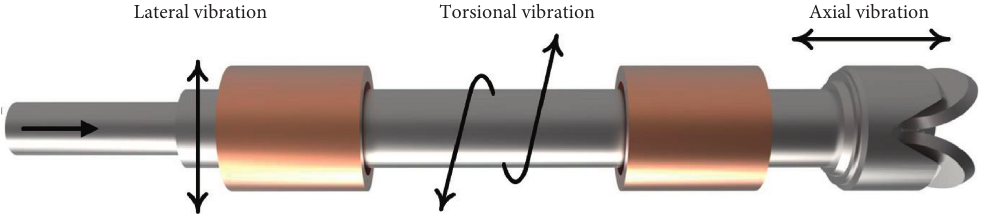
Figure 1: Vibrations of drillstring.